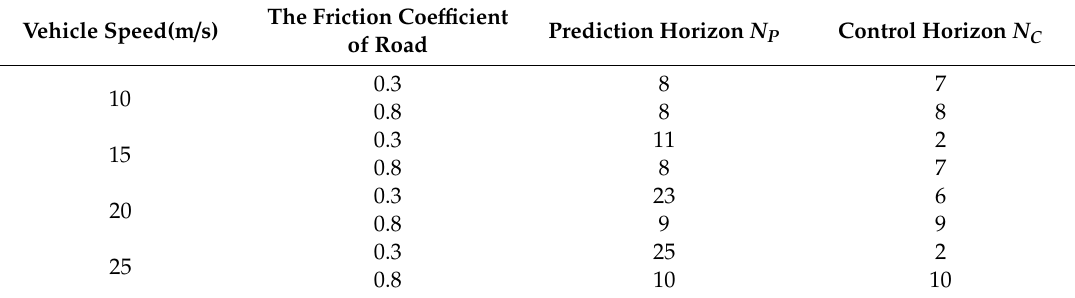
Table 2. Optimized pairs of prediction horizon and control horizon.